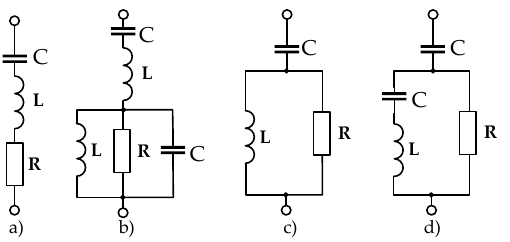
Figure 21. The main harmonic filter types: ( a ) single-tuned filter or specialized passive filter; ( b ) double-tuned filter; ( c ) high-pass filter; ( d ) C-type high-pass filter. Setting these filters to a specific frequency or frequency range depends on the set values of resistance R, inductance L, capacity C, and the circuit